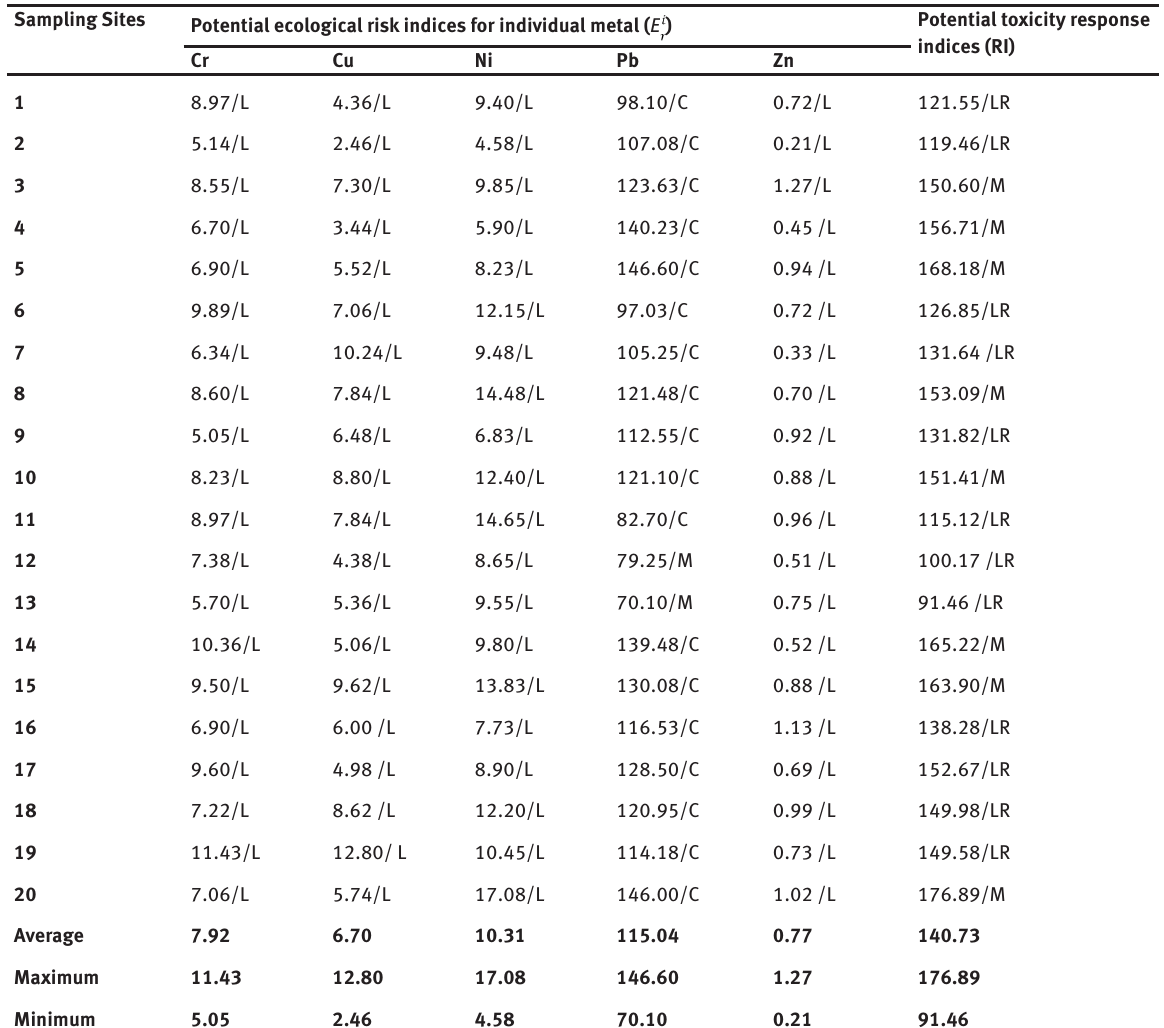
Table 7: Potential ecological risk index ( E ) and potential toxicity response Indices (RI) of heavy metals. Sampling